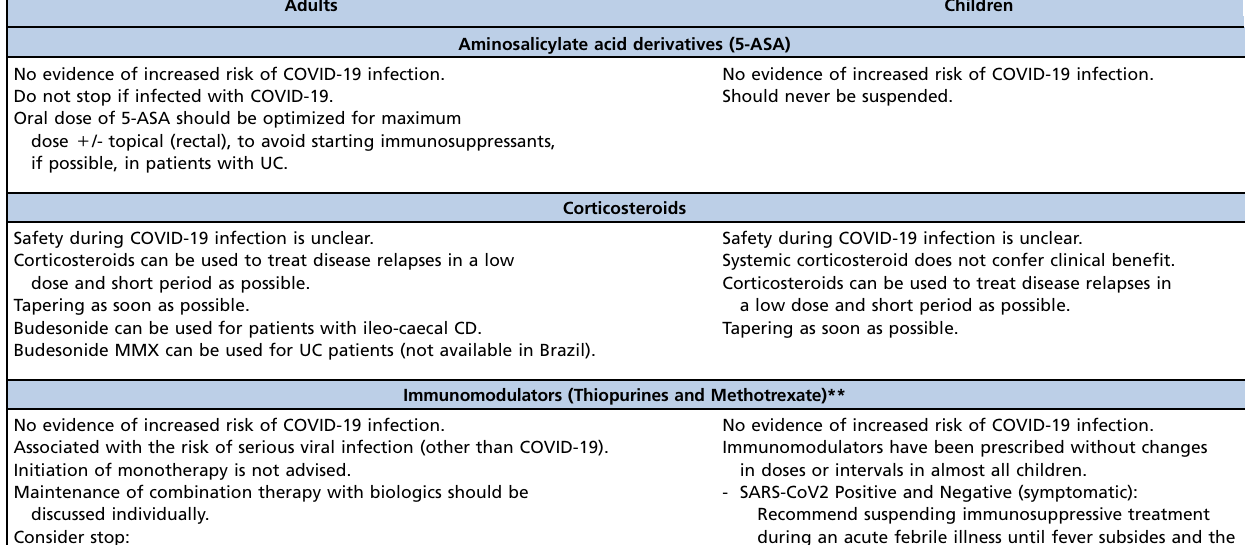
Table 3 - Therapy-specific considerations for inflammatory bowel disease patients (UC=ulcerative colitis; CD=Crohn ’ s disease). Adults Children Aminosalicylate acid derivatives